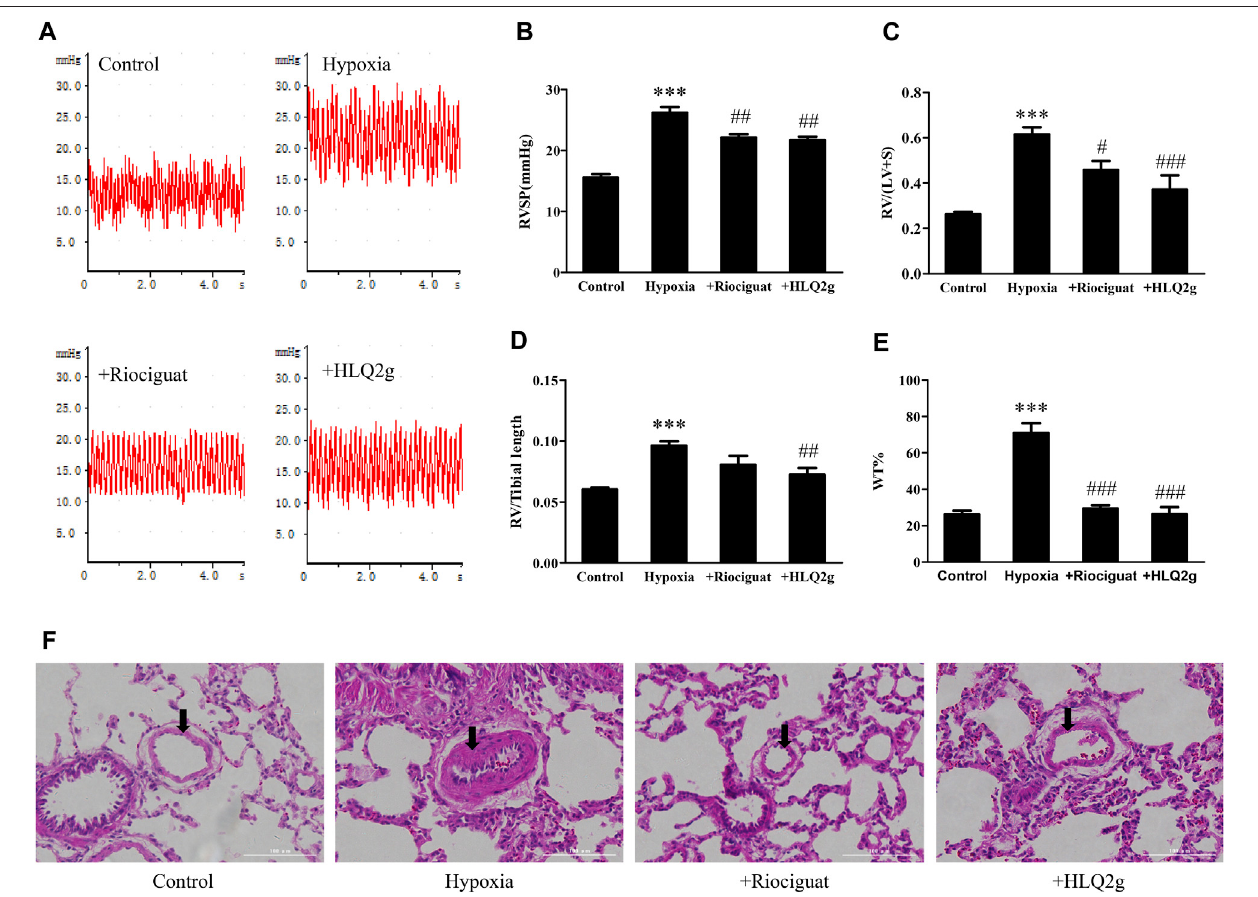
FIGURE2| Hemodynamics,rightheartremodeling,pulmonaryvascularremodelinginHypoxia-inducedPHrats. (A) :RVSPwaveform; (B) :RVSPsummarygraph; (C) : RV/LV + S ( right ventricle/ left ventricle + interventricular septum) statistics; (D) : RV/Tibial length ( right ventricle/tibial length) statistics; (E) : Statistical chart of HE staining (100 μ m); (WT%) (cid:1) (outside diameter-inside diameter)/(outside diameter) × 100. (F) : Representative image of HE staining. Control: the control rats; Hypoxia: Hypoxia-induced PH rats. Data are expressed as mean ± SD. n (cid:1) 3 – 5. Vs. the control, *** p < 0.001; vs. the Hypoxia group, # p < 0.05, ## p < 0.01, ### p < 0.001.